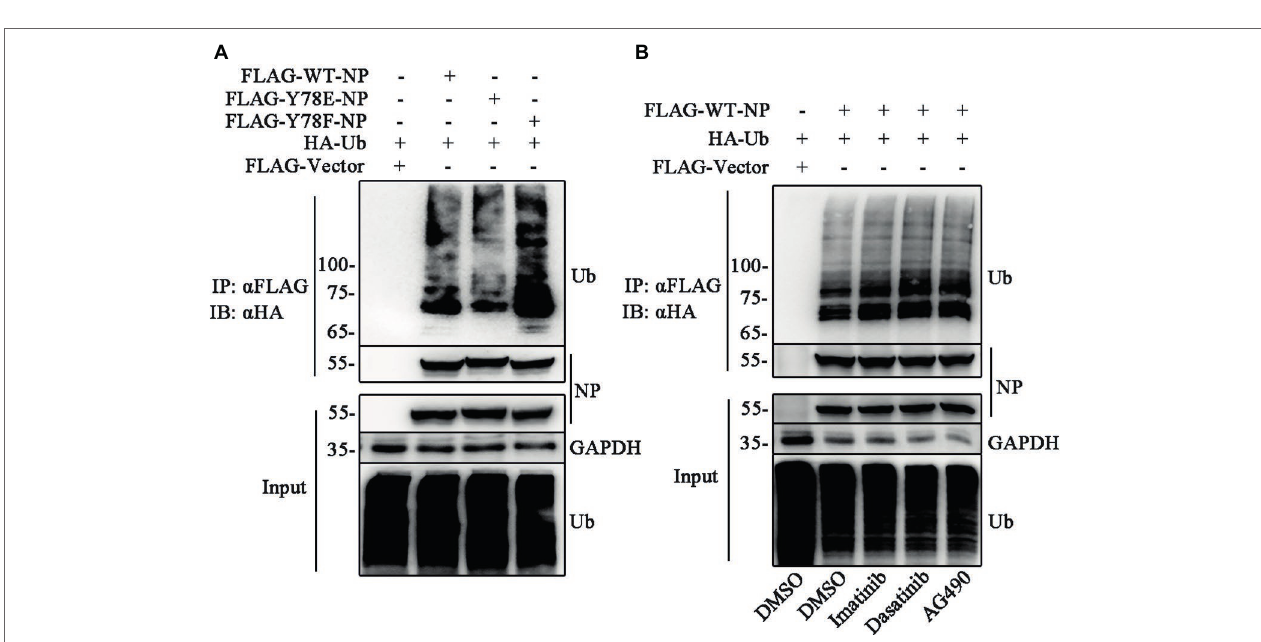
FIGURE 7 | Y78 phosphorylation inhibits NP ubiquitination. (A) Effect of Y78 phosphorylation on NP ubiquitination. 293 T cells were transfected with FLAG-tagged NPs and HA-tagged ubiquitin (HA-Ub). Cell extracts were immunoprecipitated with anti-FLAG beads at 30 h.p.t., and the ubiquitination was detected using rabbit anti-HA antibody. (B) Effect of tyrosine kinase inhibitors on NP ubiquitination. 293 T cells were transfected with FLAG-tagged WT NP and HA-tagged ubiquitin (HA-Ub). At 30 h.t.p., cells were treated with DMSO or inhibitors for 6 h. Cell extracts were immunoprecipitated with anti-FLAG beads and the ubiquitination was detected using rabbit anti-HA antibody.